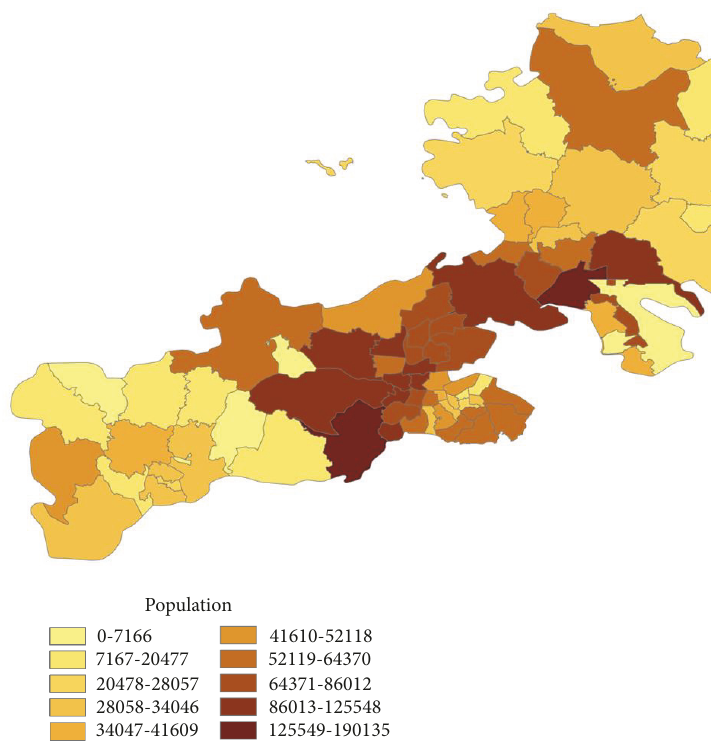
Figure 5: Distribution of population on the township scale.